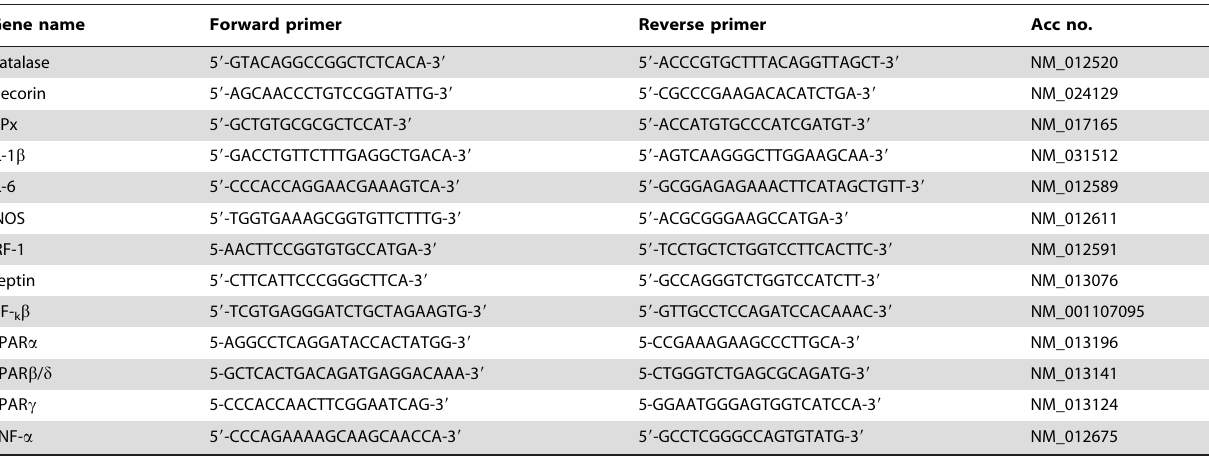
Table 1. RT-qPCR